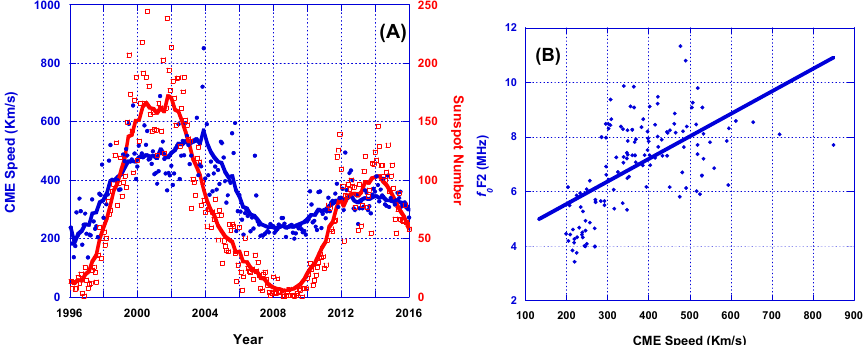
Figure 4. The time series of the monthly average values CME initial speed (Km/s) and that of the sunspot numbers (SSN) during the period 1996–2013 ( A ), and the relationship between F values and the monthly average CMEs initial speeds ( B ). The blue color of the left axis values, smooth curve and round points of plot ( A ) refer to f 0 F2 values, while the red color of the right axis values, smooth curve, and square points denote to the sunspot numbers.